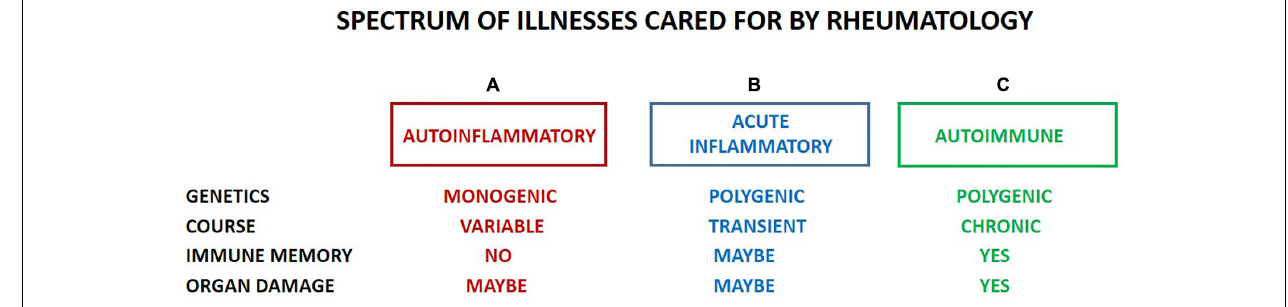
FIGURE 1 | Pediatric rheumatology is involved in inflammatory conditions in children that range from monogenetic (A) , i.e., autoinflammatory syndromes to polygenic (B,C) . The latter can be one time occurrence ( B ; such as Kawasaki Disease or MIS-C) or chronic and long term (C) . Autoimmune conditions (C) can be systemic (i.e., affecting 2 or more target organs; such as SLE, JDMS, SSc) or single organ specific (such as Rheumatoid factor + RA, T1DM, autoimmune thyroiditis, uveitis, IBD and Multiple Sclerosis). We postulate that most conditions under B are triggered by infections and the determining factor between the two polygenic inflammatory conditions (B,C) is the presence or absence of an adversary immune memory. Should breakage of tolerance occur, there might be a progression from (B,C) (such as reactive arthritis to chronic arthritis) at varying speed and intensity based on host HLA, genetic risk factors, immune -repertoire and -memory, and the properties of the triggering